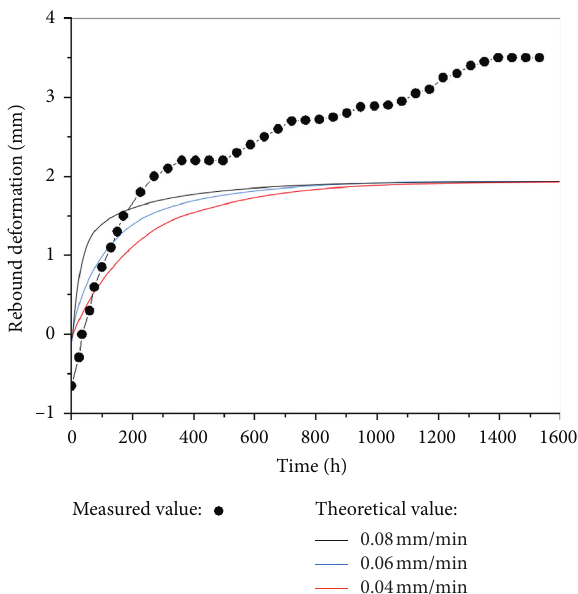
Figure 19: Comparison between calculated and measured values of rebound at different unloading